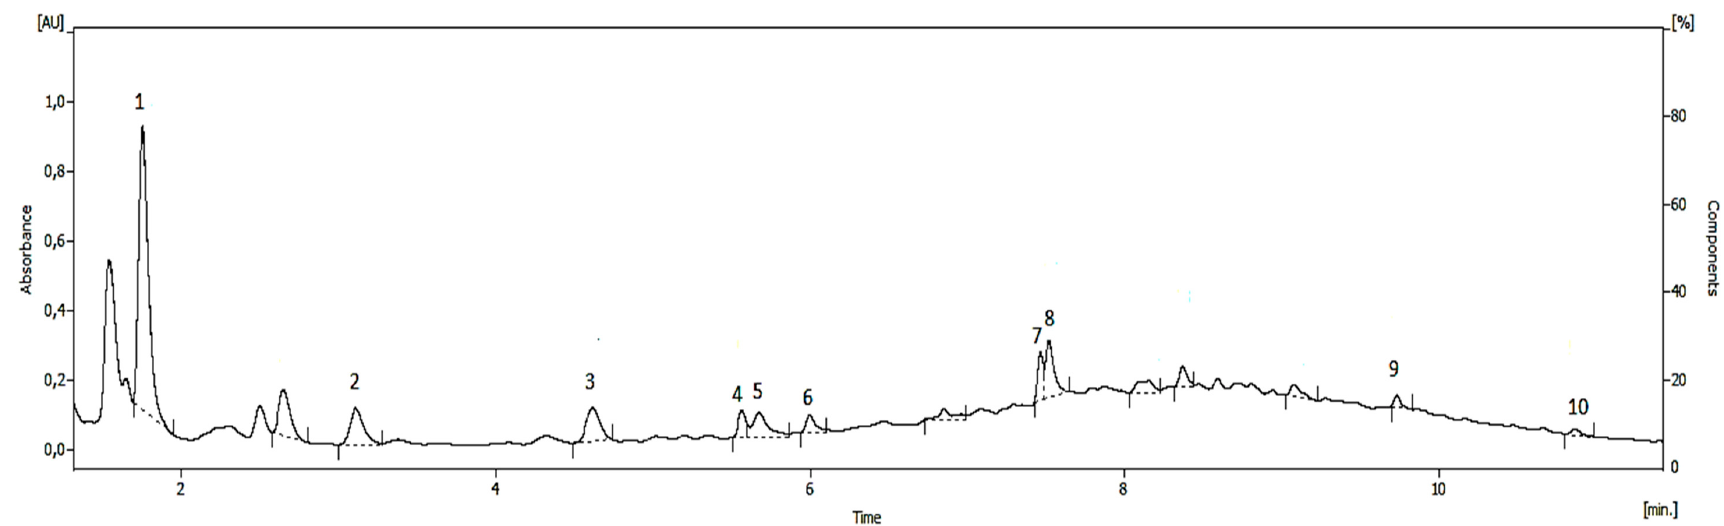
Figure 1. Chromatogram of phenolic compounds in wastewaters extract (WE). (1) hydroxytyrosol; (2) tyrosol; (3) chlorogenic acid; (4) vanillic acid; (5) caffeic acid; (6) p -coumaric acid; (7) verbascoside; (8) luteolin; (9) oleuropein; (10) apigenin.